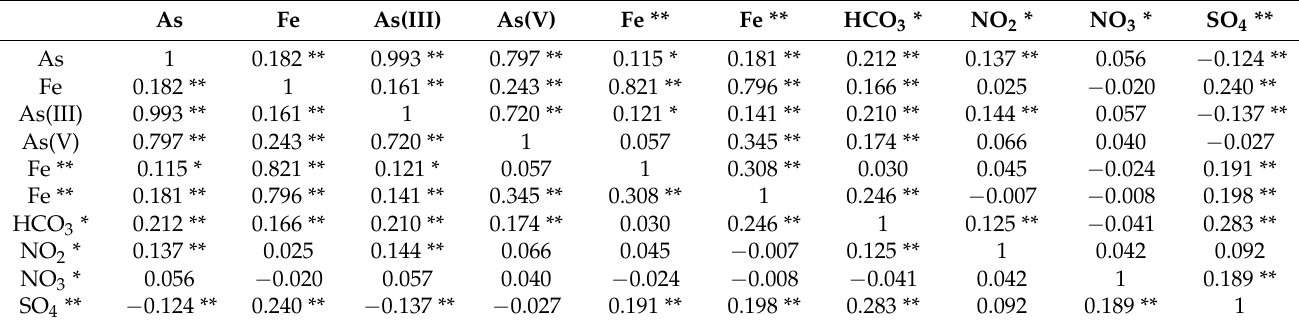
Table 5. Pearson correlation analysis between As and the main redox ions in the Houtao Plain ( n = 190).